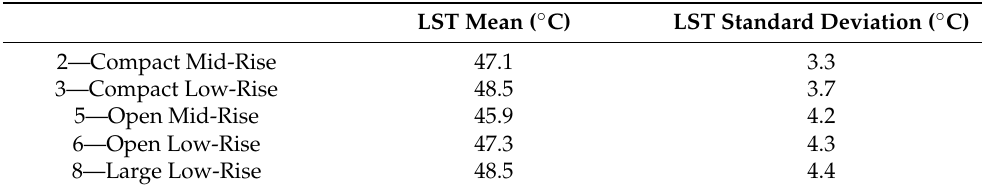
Table 5. LST statistics for artificial